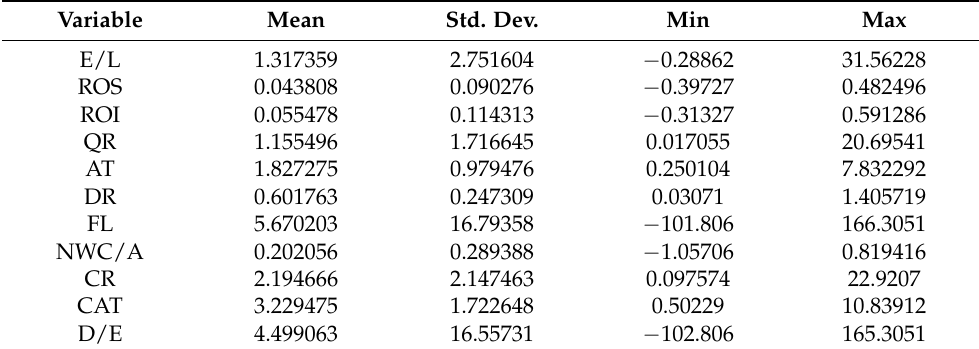
Table 3. Descriptive statistics of variables entering the